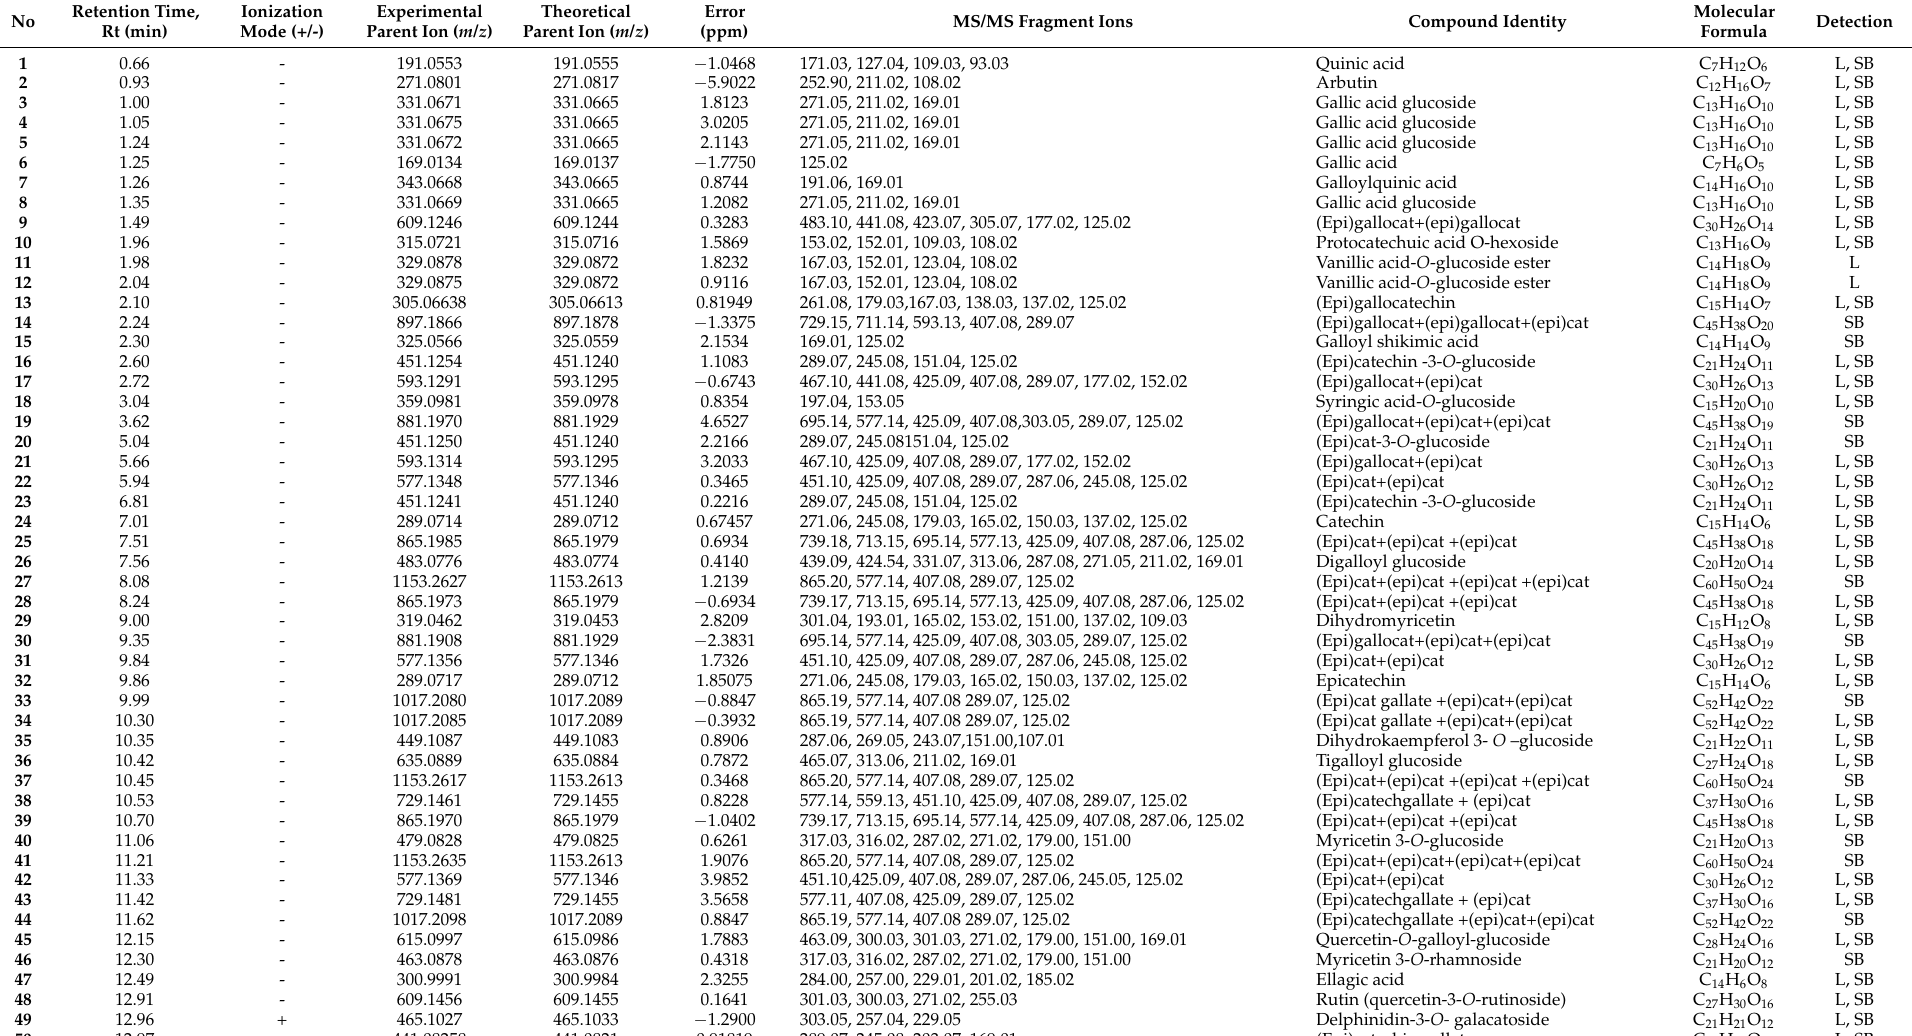
Table 2. Compounds detected and identified in the leaf and stem bark methanol extracts of A. pavarii